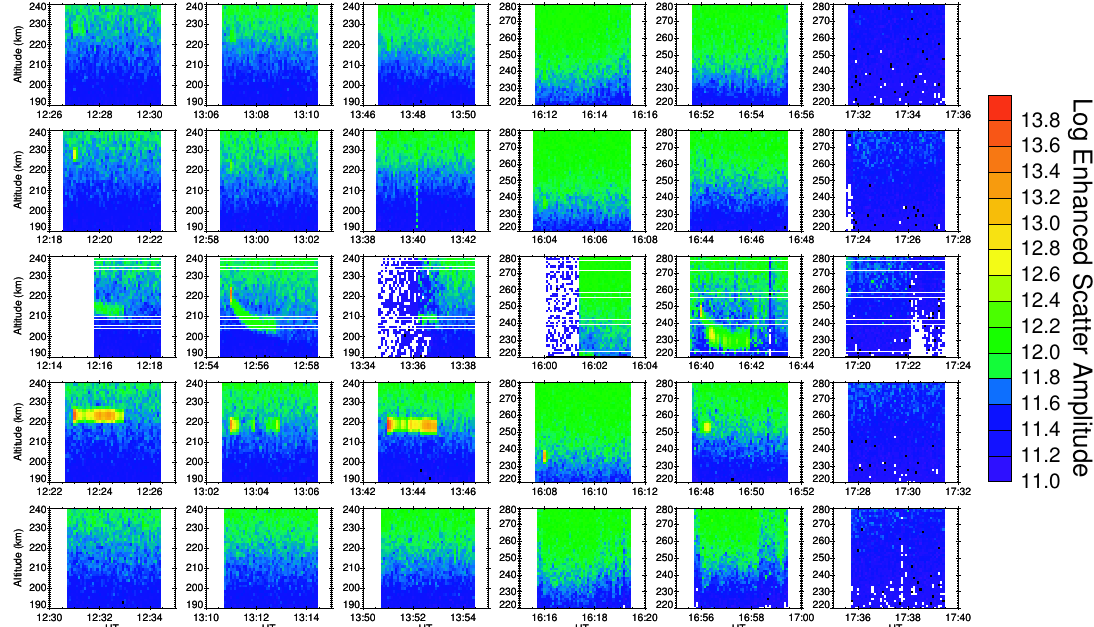
Fig. 3. Backscatter amplitudes for 12:00–18:00 UT on 26 September 2002 for FA heater pointing. The data are shown in the same format as for Fig. 2. The descending signature in FA is again present. There is also a persistent signature in FA − 6. This signature is characterized by EUS that does not descend and whose amplitude remains high throughout the on period.